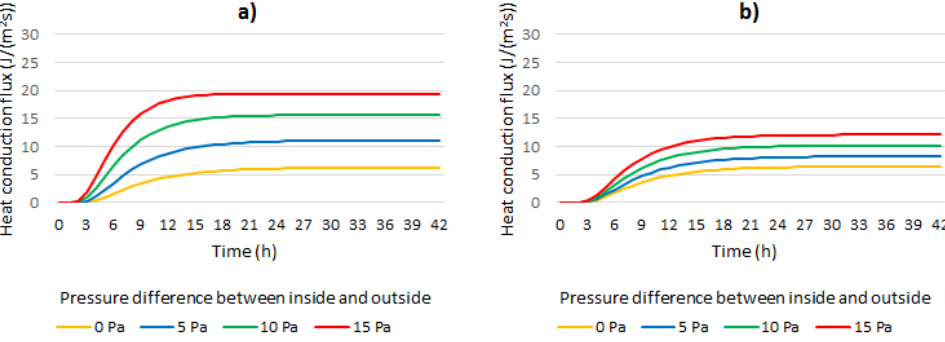
Figure 11. Heat conduction flux through the wall with 200 mm thickness of hemp fiber insulation with density of: 110 kg/m 3 ( a ) and 120 kg/m 3 ( b ) .